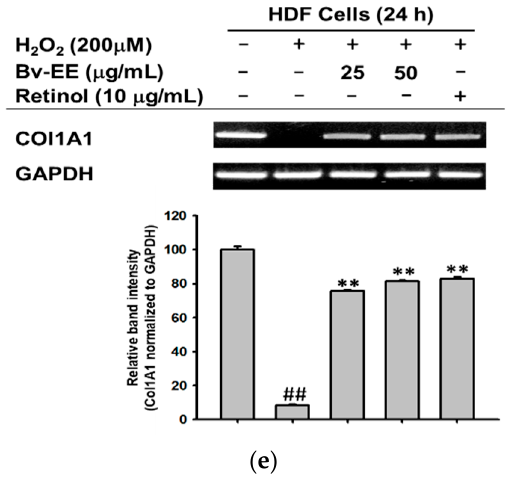
Figure 6. Bv-EE promotes collagen generation in human dermal fibroblast cells. ( a ) The viability of HDF cells treated with Bv-EE (12.5–200 μ g/mL) was measured using the MTT assay. ( b ) HEK293T cells transfected with Col1A1-Luc were treated with Bv-EE (25 and 50 μ g/mL) or retinol (10 μ g/mL) for 24 h and then examined by luminometer. ( c ) HDF cells were treated with different concentrations of Bv-EE (25 and 50 μ g/mL) or retinol (10 μ g/mL) for 24 h. ( d ) HDF cells were pretreated with Bv-EE for 30 min and then subjected to H 2 O 2 for 24 h. ( e ) HDF cells were irradiated with UVB and treated with Bv-EE for 24 h. ( c – e ) The mRNA expression level of Col1A1 was determined using semiquantitative RT-PCR. All results are expressed as means ± standard deviations. ## p < 0.01 compared with the positive control group, and * p < 0.05, ** p < 0.01 compared with the normal group.